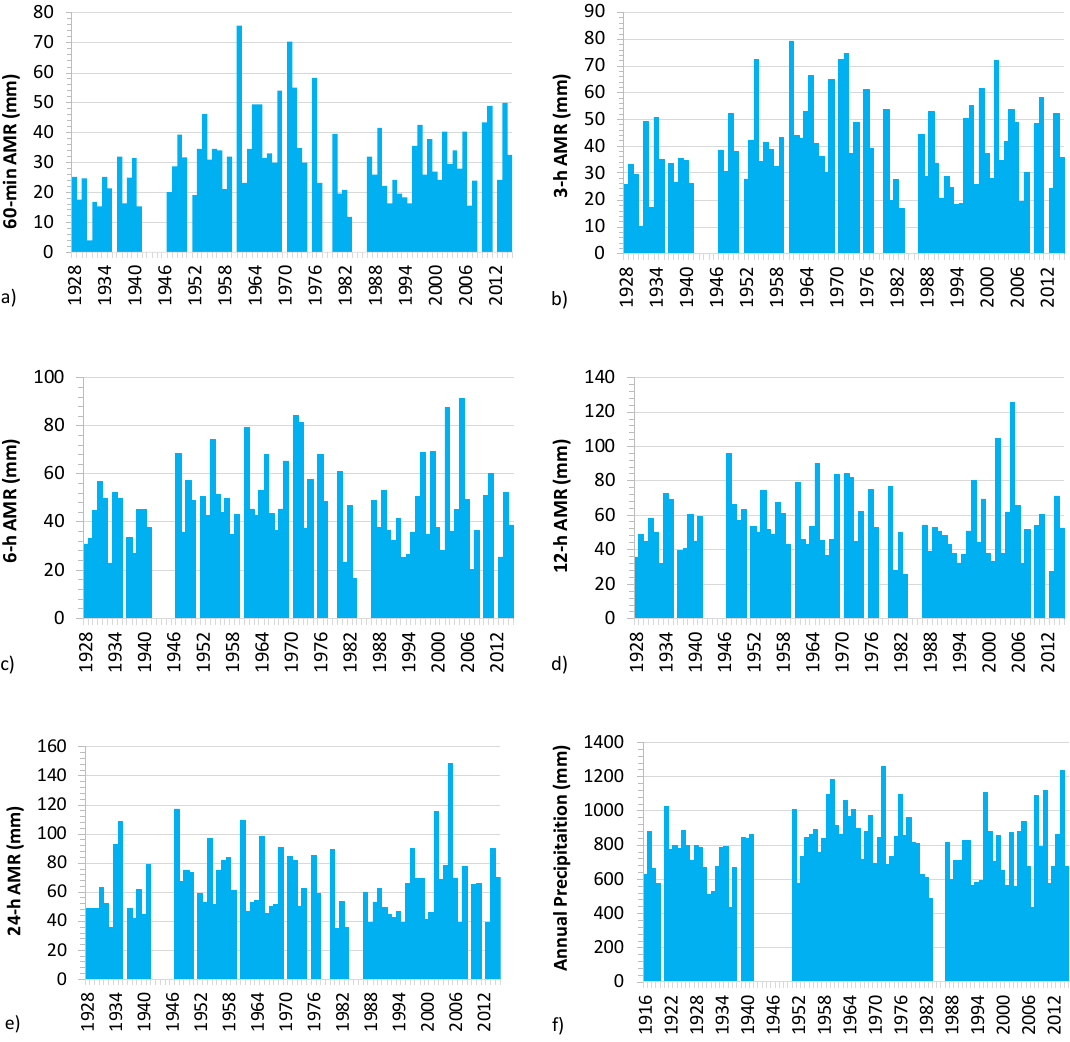
Table 2. Calibration results of the stationary version of NSRP model for Viterbo rain gauge. ⁄ 𝟏 𝝀 𝟎